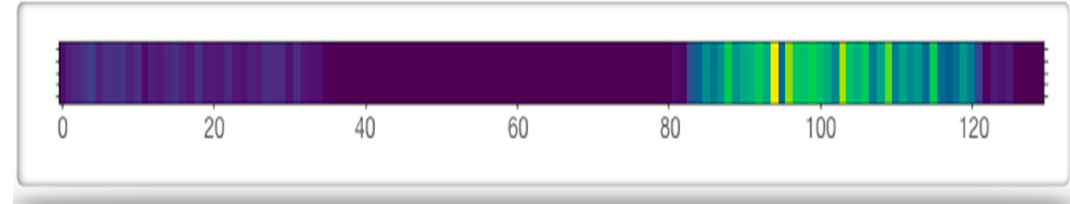
Figure 10. Visualization of the words weight 14_8.